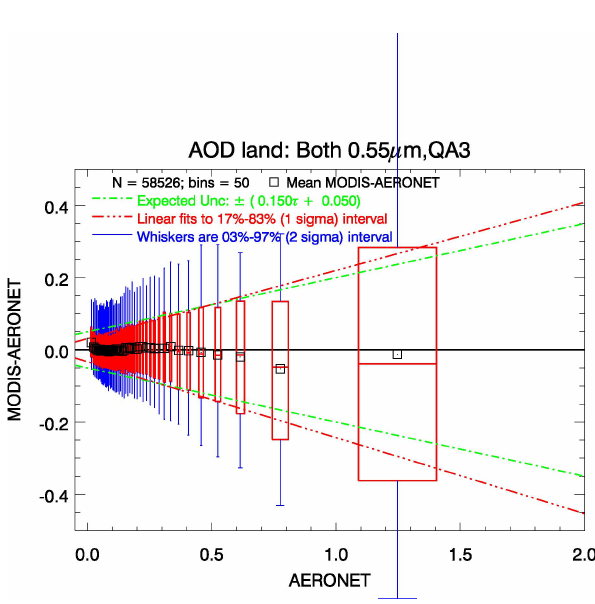
Fig. 3. Absolute error of AOD (MODIS-AERONET) at 0.55µm vs. AERONET-derived AOD at 0.55µm, for QAC=3. The x-axis is the AERONET derived AOD, and the y-axis is the ab- solute MODIS-AERONET AOD difference. Data are sorted by AERONET AOD and grouped into 50equal bins. Each boxplot represents the statistics of the MODIS-AERONET differences in the bin. The means and standard deviations of the AERONET AOD are the centers and half widths in the horizontal (red). The mean, medians, and 66% (1- σ ) interval of the MODIS-AERONET differ- ences are the black squares, the center, and top-bottom red intervals in the vertical (also red). The blue whiskers are the 96% (2- σ ) in- tervals. The red dashed curves are linear best fits to the 66whereas the green dashed curves represent the over-land EE for total AOD ±